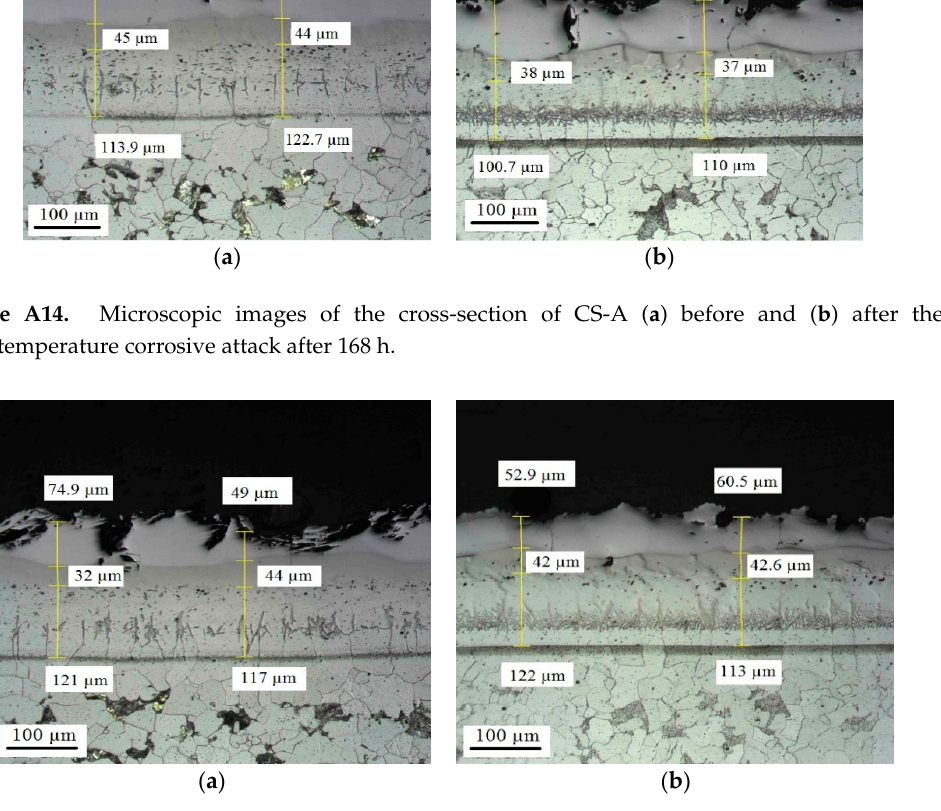
Figure A15. Microscopic images of the cross-section of CS-A-Sn ( a ) before and ( b ) after the high-temperature corrosive attack after 168 h.